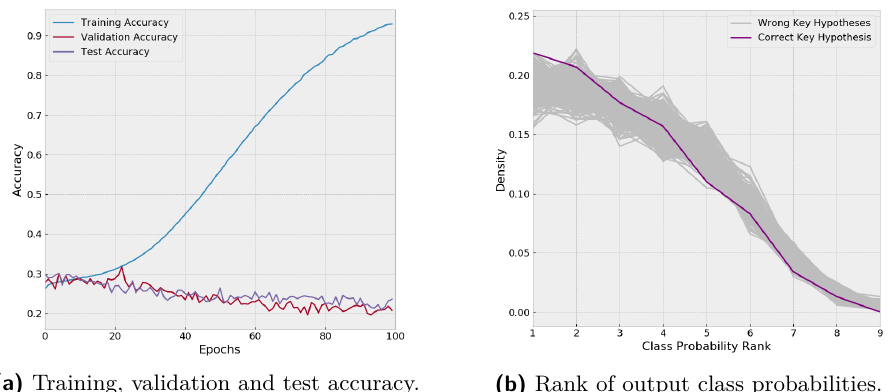
Figure 2: Machine learning metrics and class probability ranks for the ASCAD database (1 000 traces) and MLP.